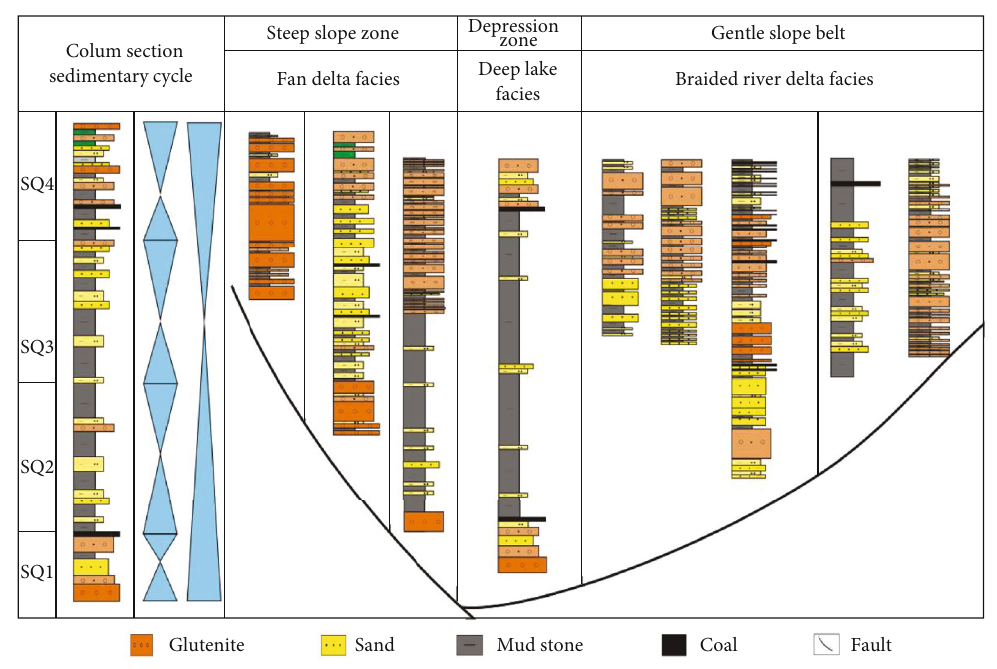
Figure 1: Sedimentary evolution model